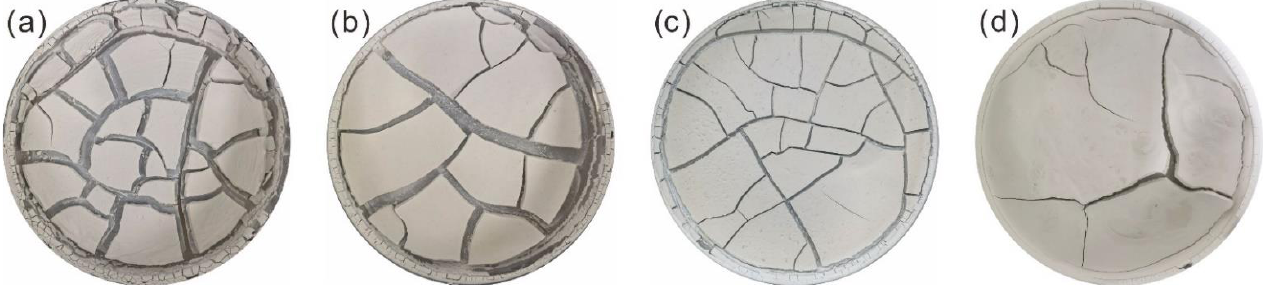
Figure 7. Distribution of crack length in samples with different BM:TC.